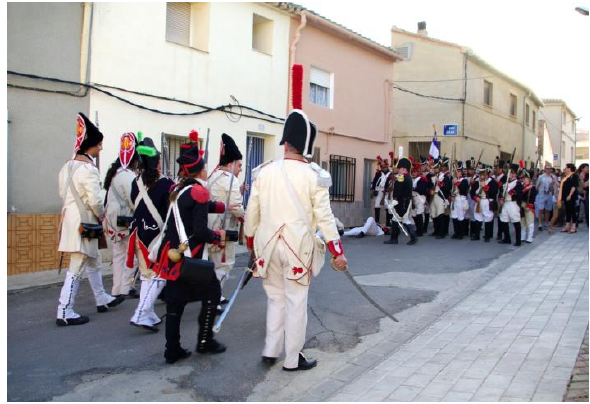
Figure 7. Social participation in commemorative events after the recovery of the trenches of Villargordo del